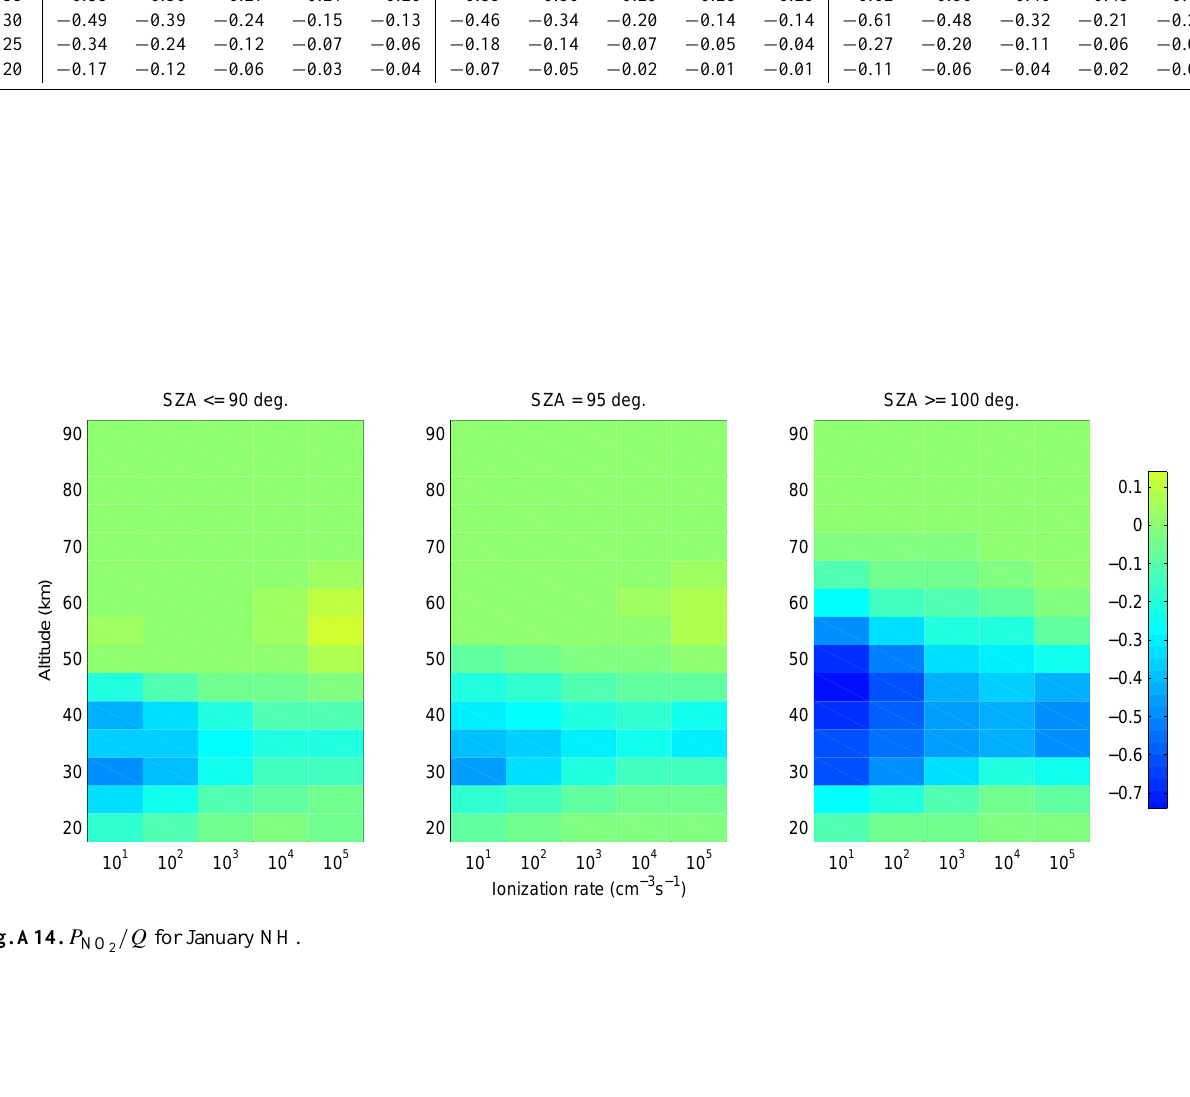
/Q for January 2